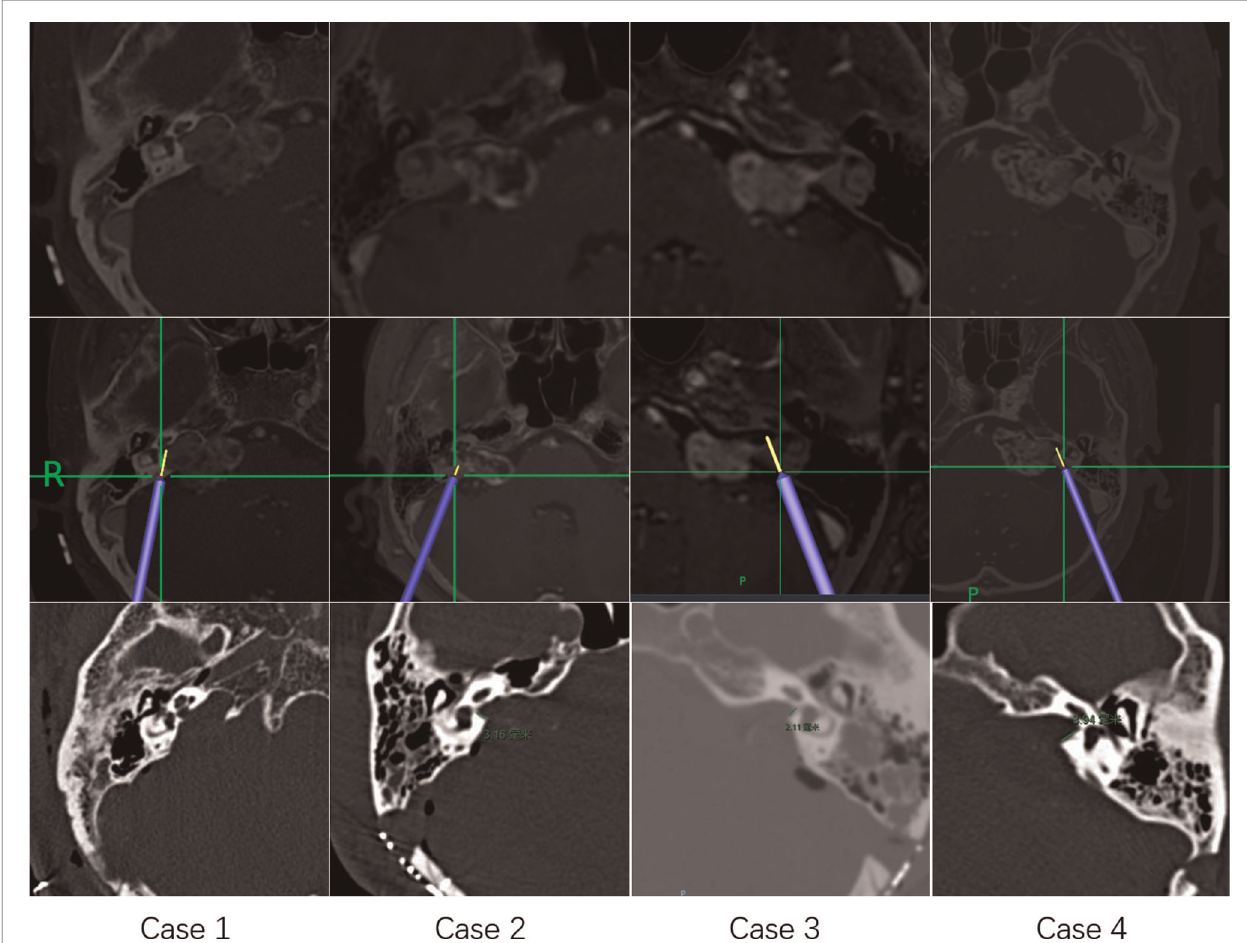
FIGURE 4 | Four illustrative cases of using navigation to locate the boundaries of drilling of the internal auditory